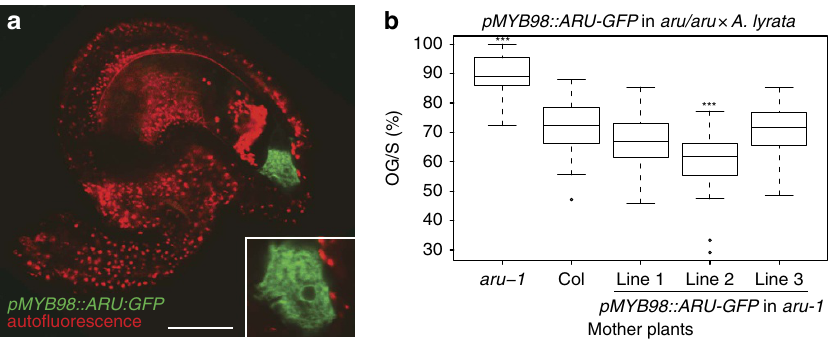
Figure 5 | Synergid-specific expression of ARTUMES complements the mutant phenotype. ( a ) An ovule expressing pMYB98::ARU-GFP in the synergids. Inset: ARU-GFP localizes to perinuclear structures resembling the ER. ( b ) PT overgrowth in interspecific crosses using aru-1 ( n ¼ 22 siliques), Col-0 ( n ¼ 28), and three independent transformant lines of pMYB98::ARU-GFP in the aru-1 background as mother plants and A. lyrata as pollen donor. All the three transformant lines complement the mutant phenotype ( n ¼ 16, 22, and 27 siliques, respectively); line 2 shows even lower OG/S than the